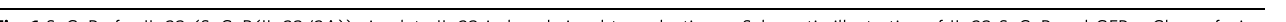
antibodies for phospho-STAT3 and STAT3. Western blot data show one representative experiment out of